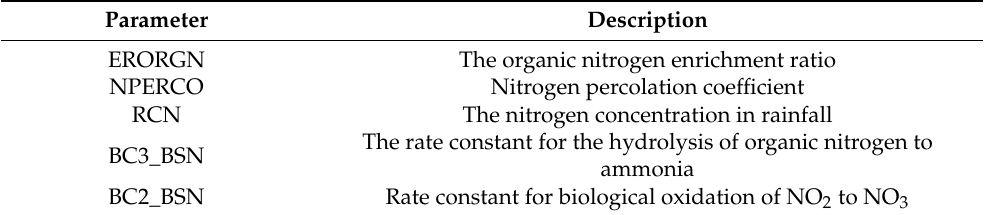
Table A2. Description of sensitive parameters for nitrate pollution in SWAT.